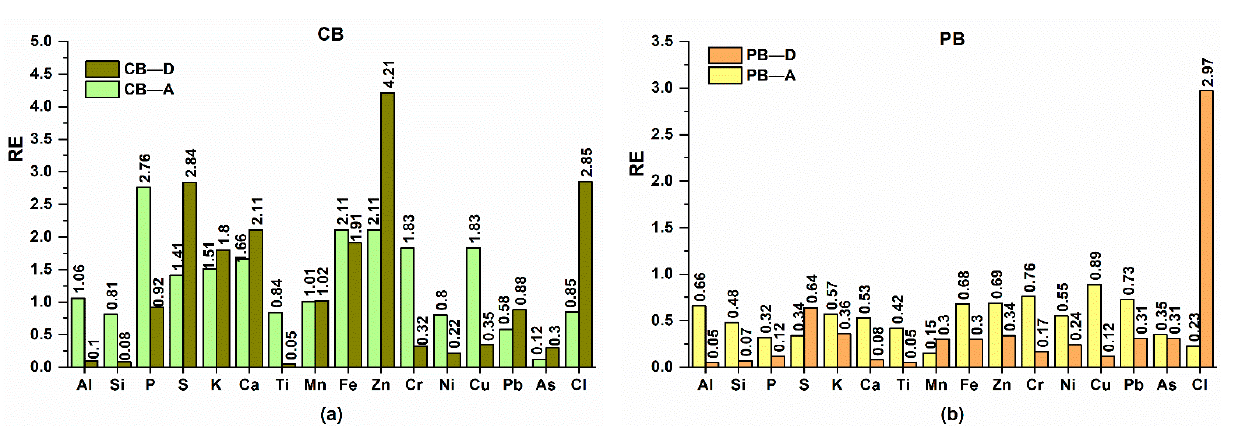
Figure 8. RE values for elements contained in ash and deposits from the combustion of CB ( a ) and PB ( b ); RE = Concentration of element in ash/ash percentage in the feed coal × Concentrations of elements in coal/100.